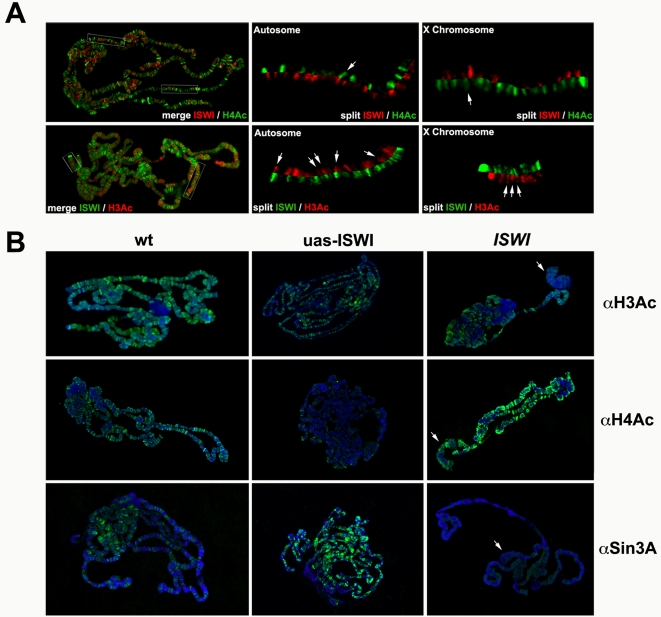
Changes in chromatin bound ISWI affects the levels of acetylated histone H3 and H4.(A) Immunofluorescence detection of ISWI [red] and acetylated histone H4 [green; K5Ac, K8Ac, K12Ac, K16Ac] on wild-type salivary gland polytene chromosomes [upper panel]. The distributions of ISWI and acetylated histone H4 are dissimilar on both autosomes and X chromosome, with few sites of overlap (arrows), as visible in the split-image magnifications. Distribution of ISWI [green] and acetylated histone H3 [red; K9Ac, K14Ac] on wild-type salivary gland polytene chromosomes [lower panel]. ISWI share a good number of sites on both autosomes and X chromosome with the acetylated histone H3 (arrows), as visible in the split-image magnifications. (B) Distributions and levels of acetylated histone H3 [upper pannel], acetylated histone H4 [middle panel] and Sin3A [lower panel] on DAPI stained polytene chromosomes from w1118 strain[wt], ISWI1/ISWI2 mutant [ISWI] and from salivary glands expressing wild-type ISWI [uas-ISWI]. The specificity of αH3Ac and αH4Ac antibodies has been tested by Western on unmodified and acetylated histone substrates (data not shown). Arrows indicate the puffed X chromosome on ISWI1/ISWI2 mutant male chromosomes.